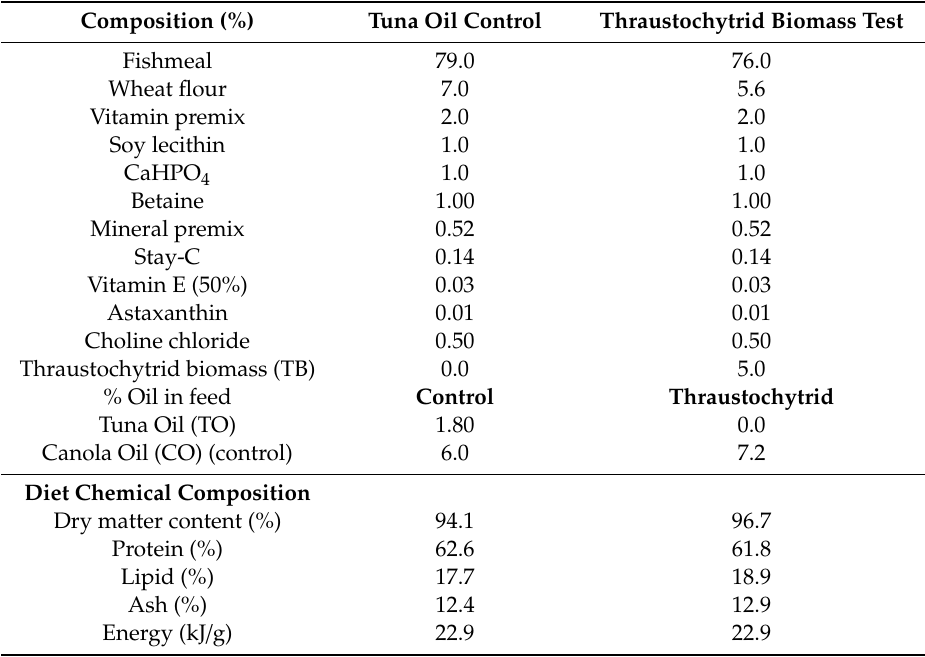
Table 1. Ingredient composition (% of total ingredient mass) and chemical composition of the experimental diets. Composition